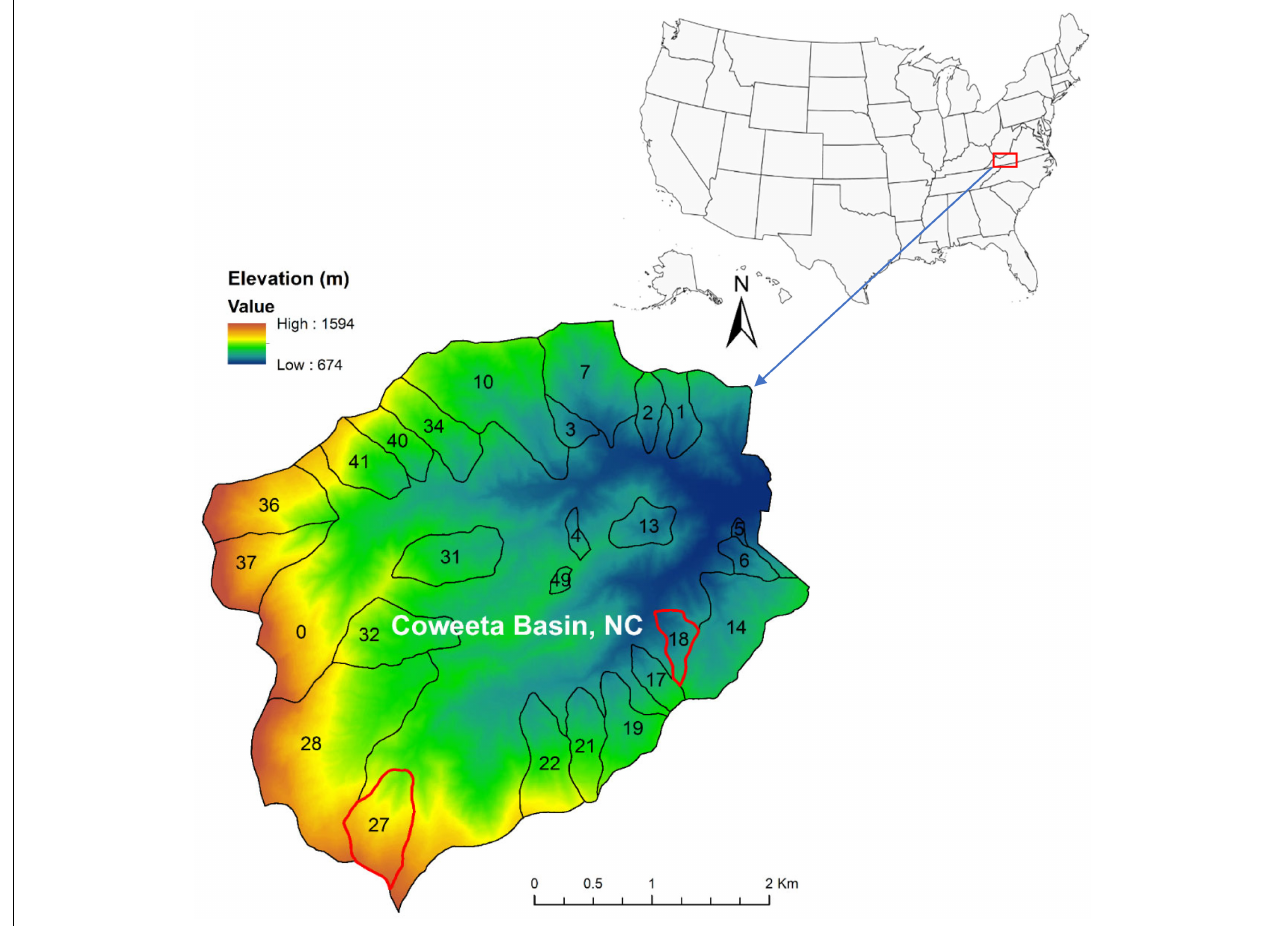
FIGURE 1 | Elevation of study area – Coweeta Basin, NC (watershed 18 – WS18 and watershed 27 – WS27 are indicated in red boundaries in the lower left panel).